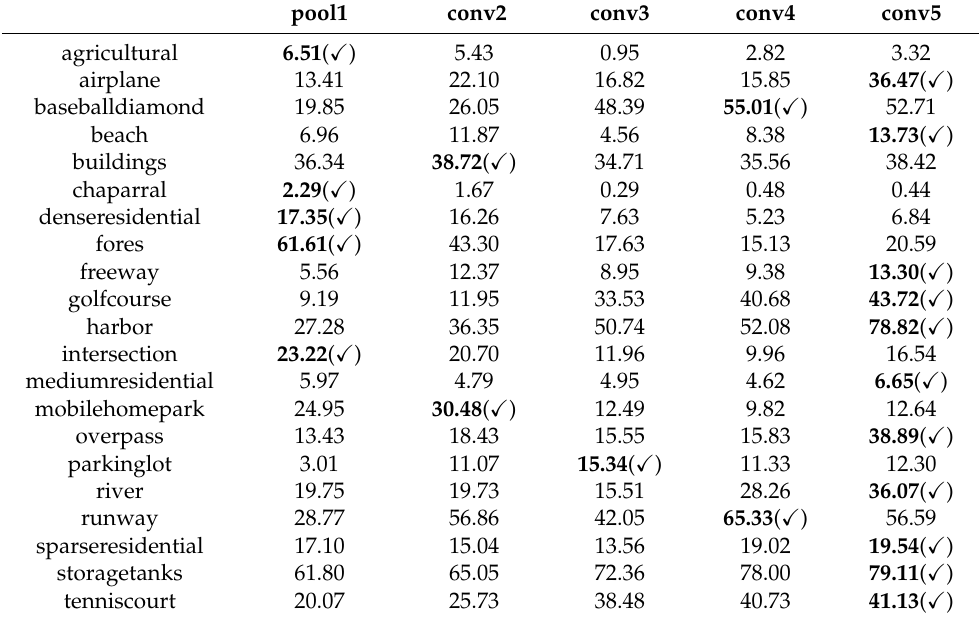
Table 2. wPO(%) of each layer from AlexNet on UCM.